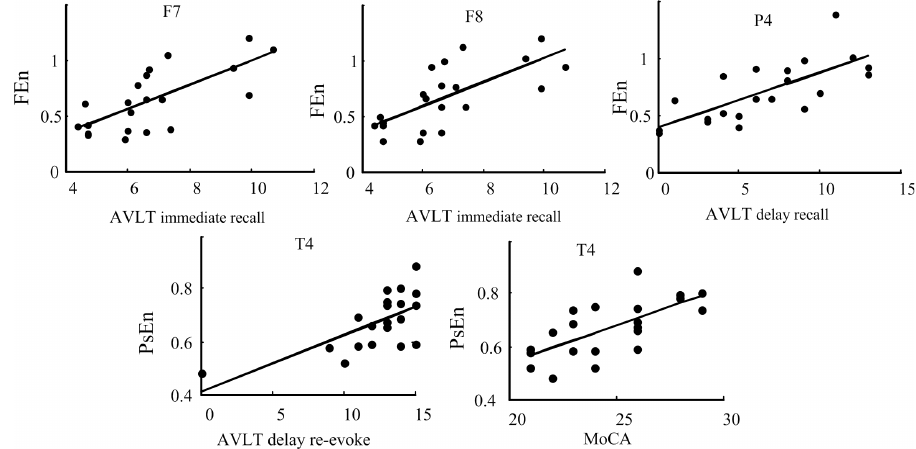
Fig. 6. Correlation results between neuropsychological tests and each entropy based on EMD for each electrode in all patients as a whole group (only signi¯cant correlations were